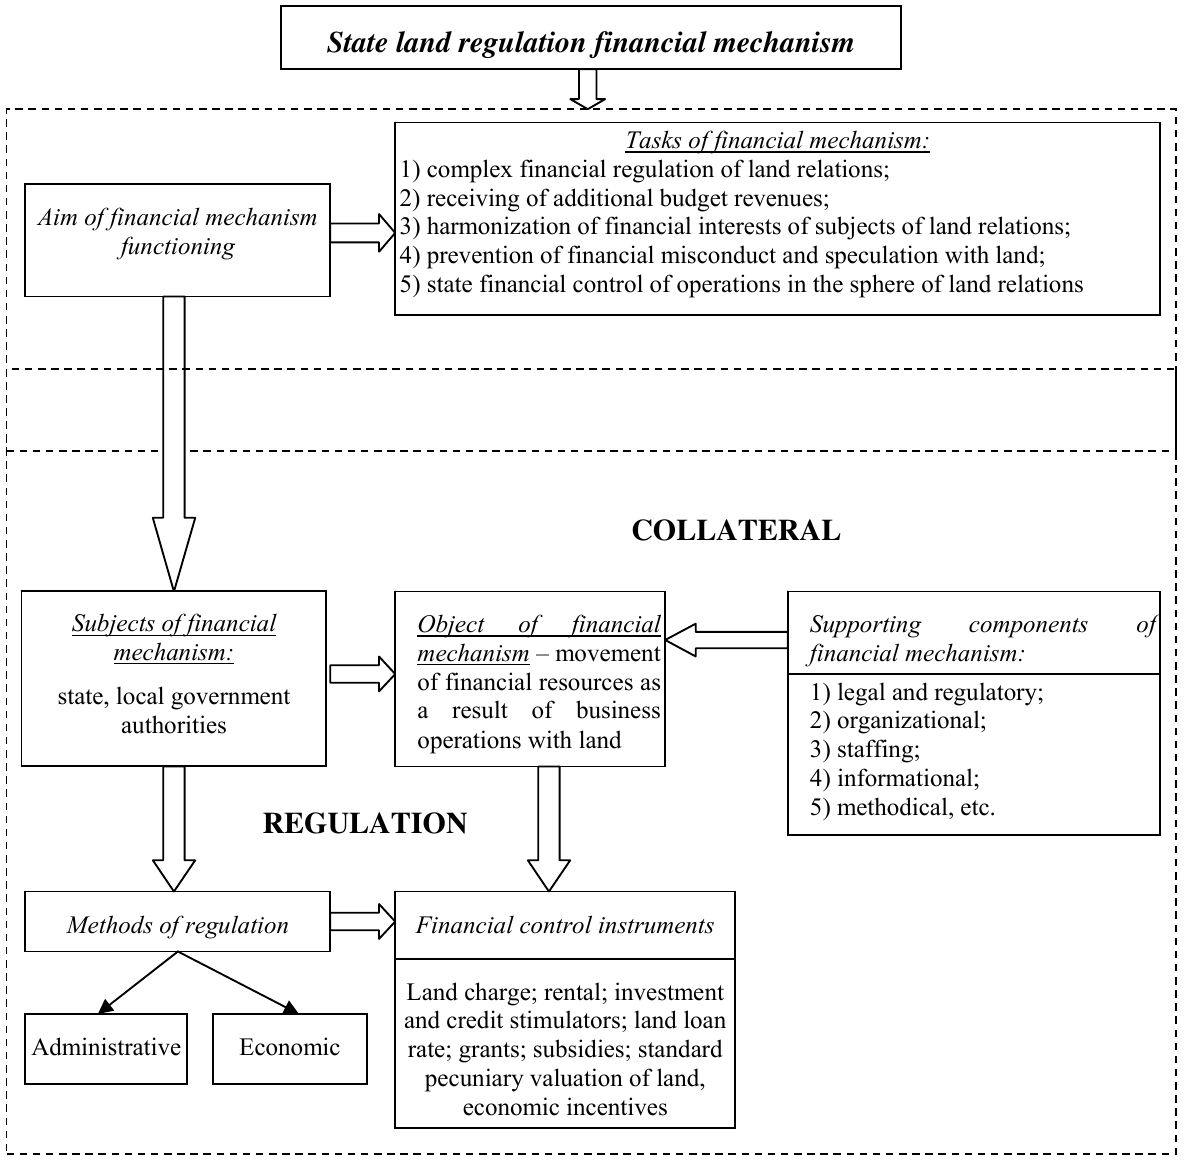
Fig. 1. Financial mechanism of state land